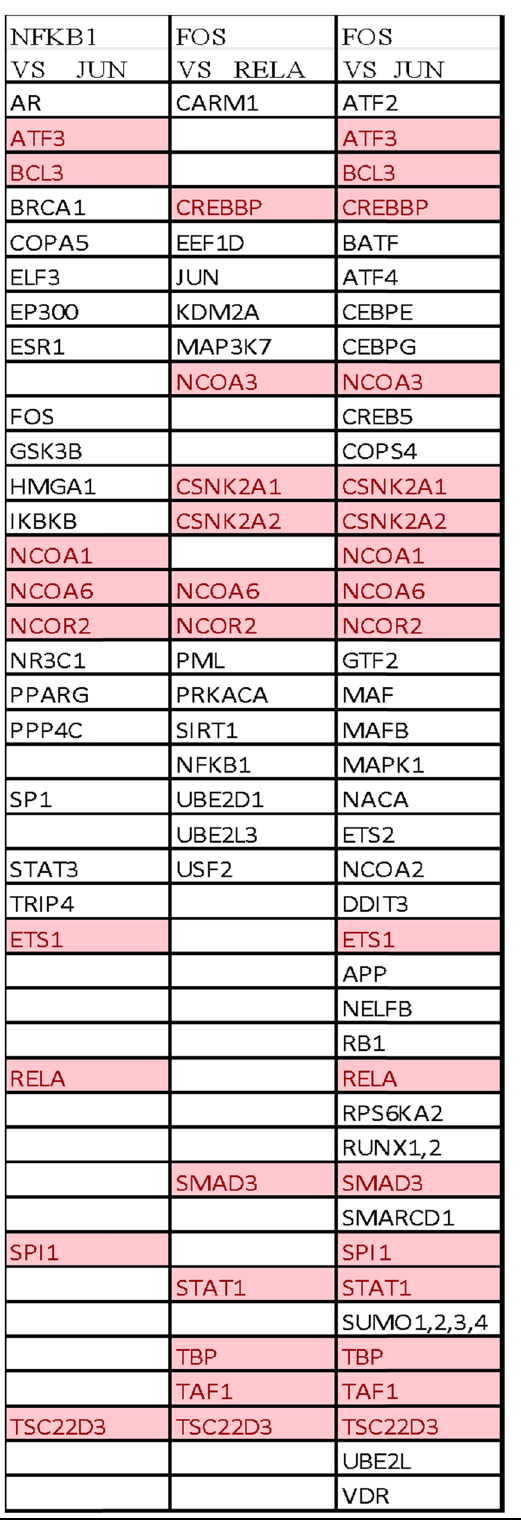
Table 2: Shared common interaction partners across NF - KB and AP1